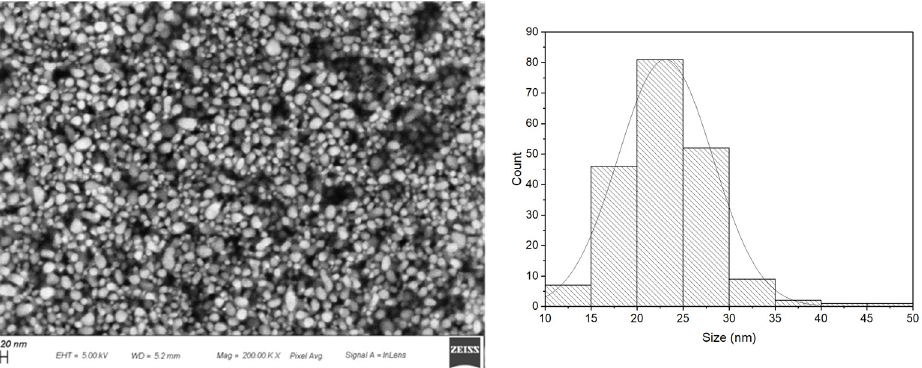
Figure 1. SEM image of AgNPs 11MUA at Mag = 200.00 K× ( left panel). Particle size distribution (~ 23.07 ± 5.12 nm) obtained by size analysis with ImageJ software ( right panel).